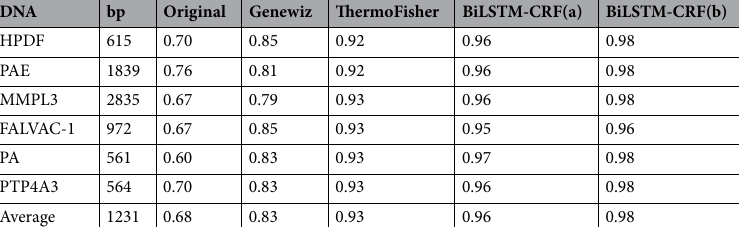
Table 2. CAI comparison between original sequences and optimized sequences. This table shows the CAIs of the sequences optimized by different optimization tools, among which the values for Genewiz and ThermoFisher are provided on their official websites (ThermoFisher: www.therm ofish er.com, Genewiz: www. genew iz.com). BiLSTM-CRF(b) has the highest average CAI, showing that it has great potential to enhance protein expression.